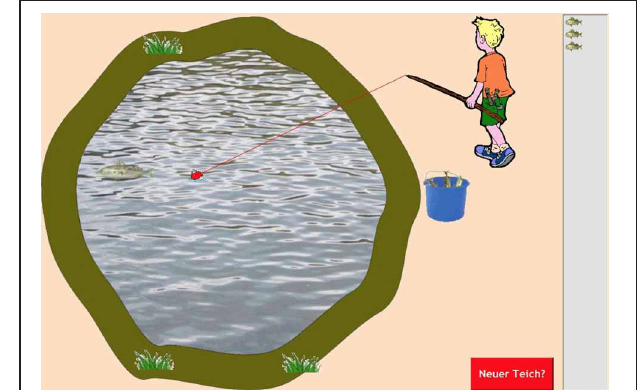
FIGURE 2 | Screenshot of the Fishing task (Czienskowski, 2005a). The fisherman is moving the float at the end of the fishing line toward a fish that appeared on the left-hand side of the pond. Three fish have already been caught at the current pond (see resource stack on the right side). Subjects can choose to move to the next pond at any time by hitting the red switch patch button (lower right). Hitting the switching button will let the fisherman walk off the screen, initiate a waiting period in which a bouncing ball animation is shown (i.e., the travel time between subsequent ponds), and ends with the fisherman walking back onto the screen to a new pond (with a centered float, no fish showing in the bucket, an emptied resource stack, and the pond redrawn with different pond margins and vegetation around it).